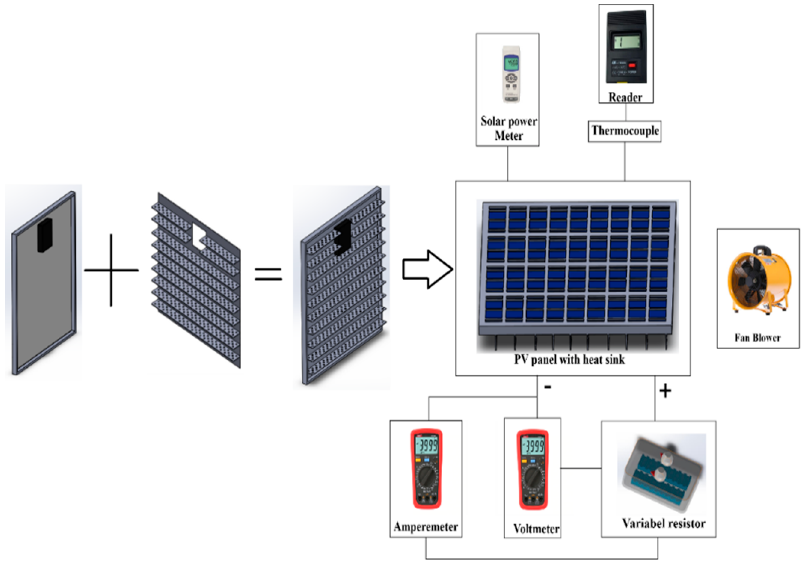
Figure 2. Experimental setup.